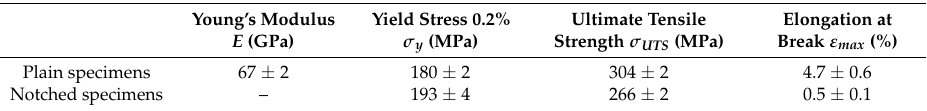
Table 2. Mechanical properties of fully dense LPBF-built AlSi10Mg specimens.